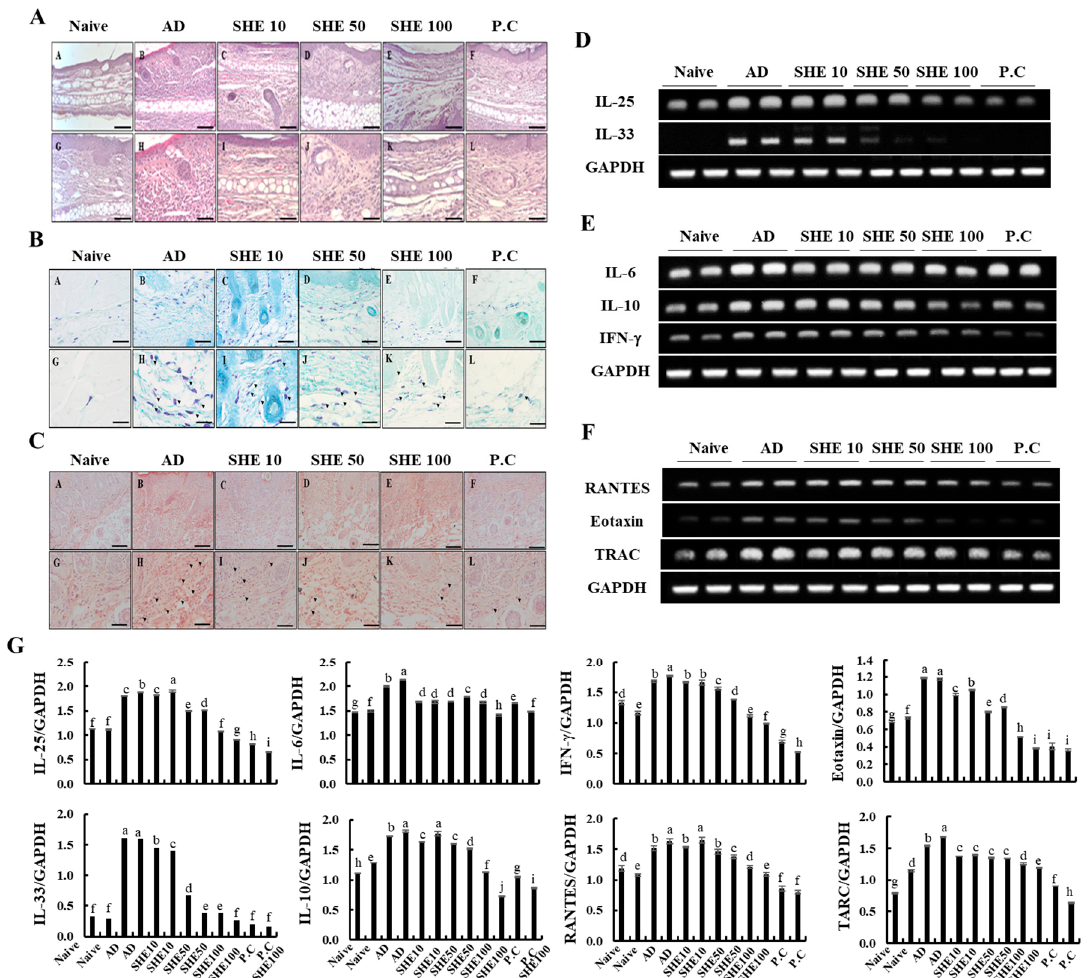
Figure 4. Results of hematoxylin and eosin-stained tissue (scale bar: 200 µ m) and regulation of allergy-mediated mRNA expression levels of cytokines and chemokines expression in skin tissues of HDM / DNCB-induced mice. ( A ) Comparison of the histopathology of dorsal skin lesions after repeated oral administration of SHE on hematoxylin and eosin- stained tissues, ( B ) toluidine blue-stained skin, ( C ) congo-red stained skin, ( D ) regulation of SHE on atopy early stimulation factors (IL-25, IL-33), ( E ) regulation of SHE on allergic mediated cytokines (IL-6, IL-10, and IFN- γ ), and ( F ) regulation of SHE on allergic mediated chemokines (RANTES, Eotaxin, and TRAC). Densitometry analysis ( G ). Experiments were performed in triplicates, to confirm repeatability. a–j Values with di ff erent alphabets were significantly di ff erent at p < 0.05 ( n = 8).